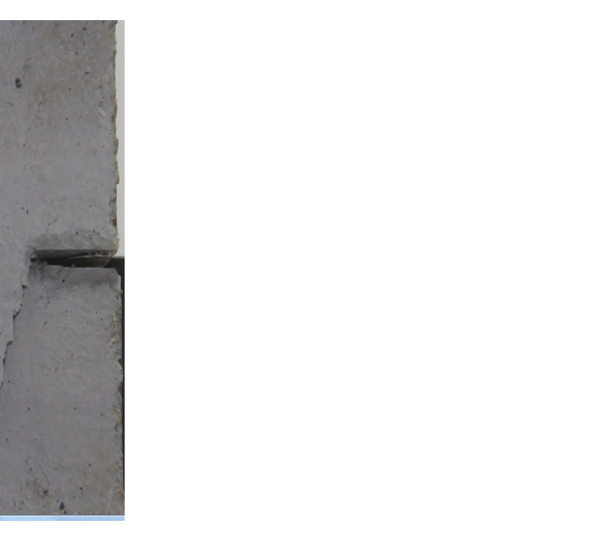
Figure 13. Photograph of a specimen showing crack